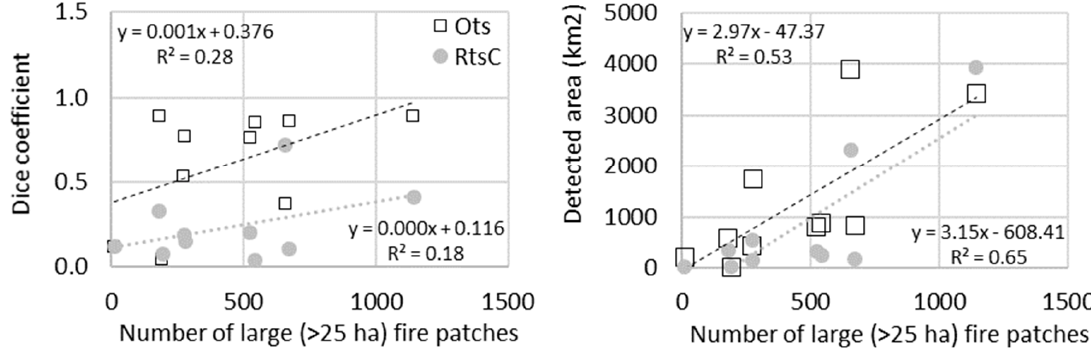
Figure 3. The relationship between detection accuracy ( left ) and detected area ( right ) for the optical- based (Ots) and interferometric coherence based (RtsC) algorithms for the 10 tiles